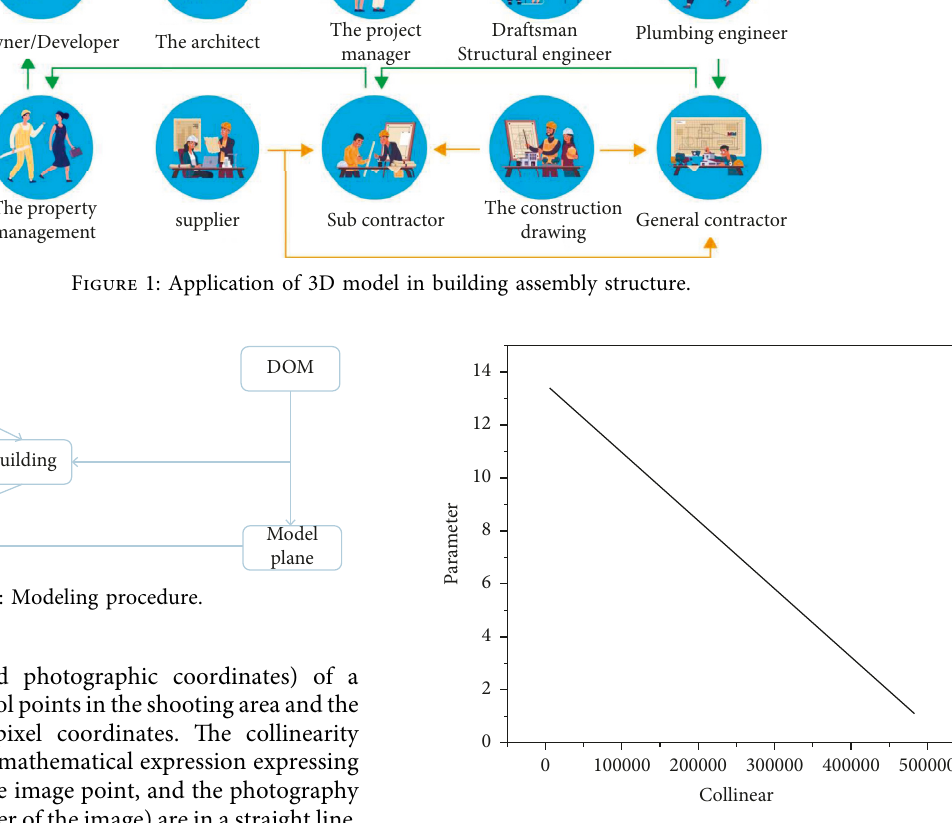
Figure 3: Schematic diagram of collinear equations.